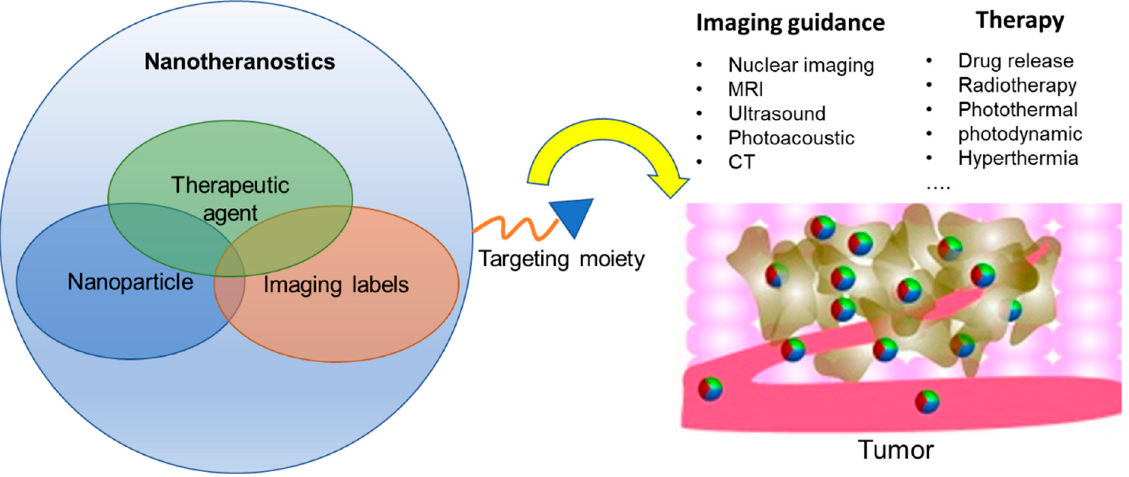
Figure 1. Overview of the multifaceted imaging and therapeutic capabilities of nanotheranostics. While nanotheranostics are composed of nanoparticle (NP), imaging labels, and therapeutic agents, the three components may overlap and NPs alone may function as imaging and therapeutic agents.